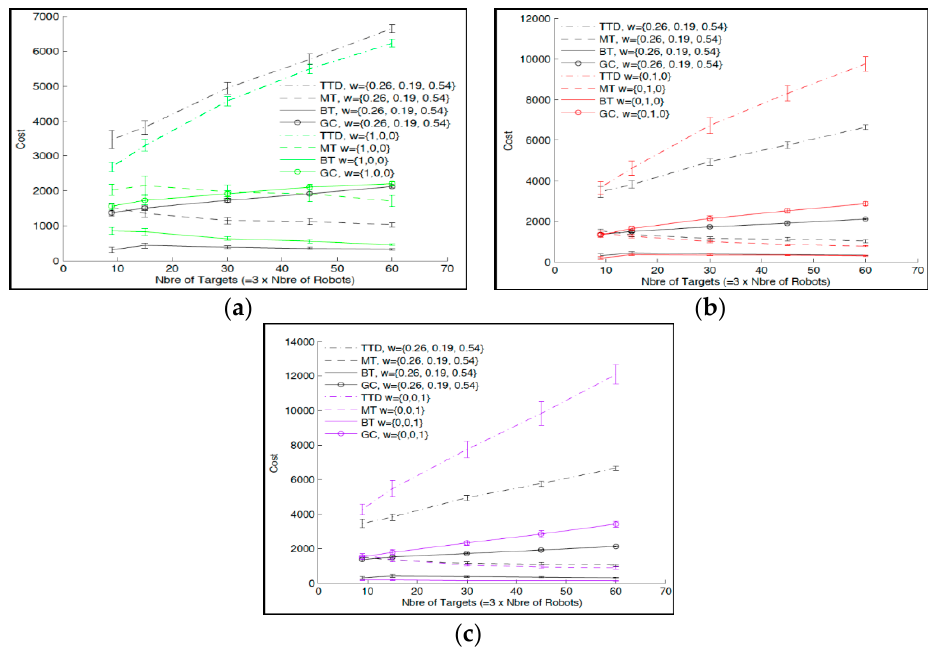
Figure 11. ( a ) AHP-MTSP comparison with mono-objective approach considering TTD. ( b ) AHP-MTSP comparison with mono-objective approach considering MT. ( c ) AHP-MTSP comparison with mono-objective approach considering DR.